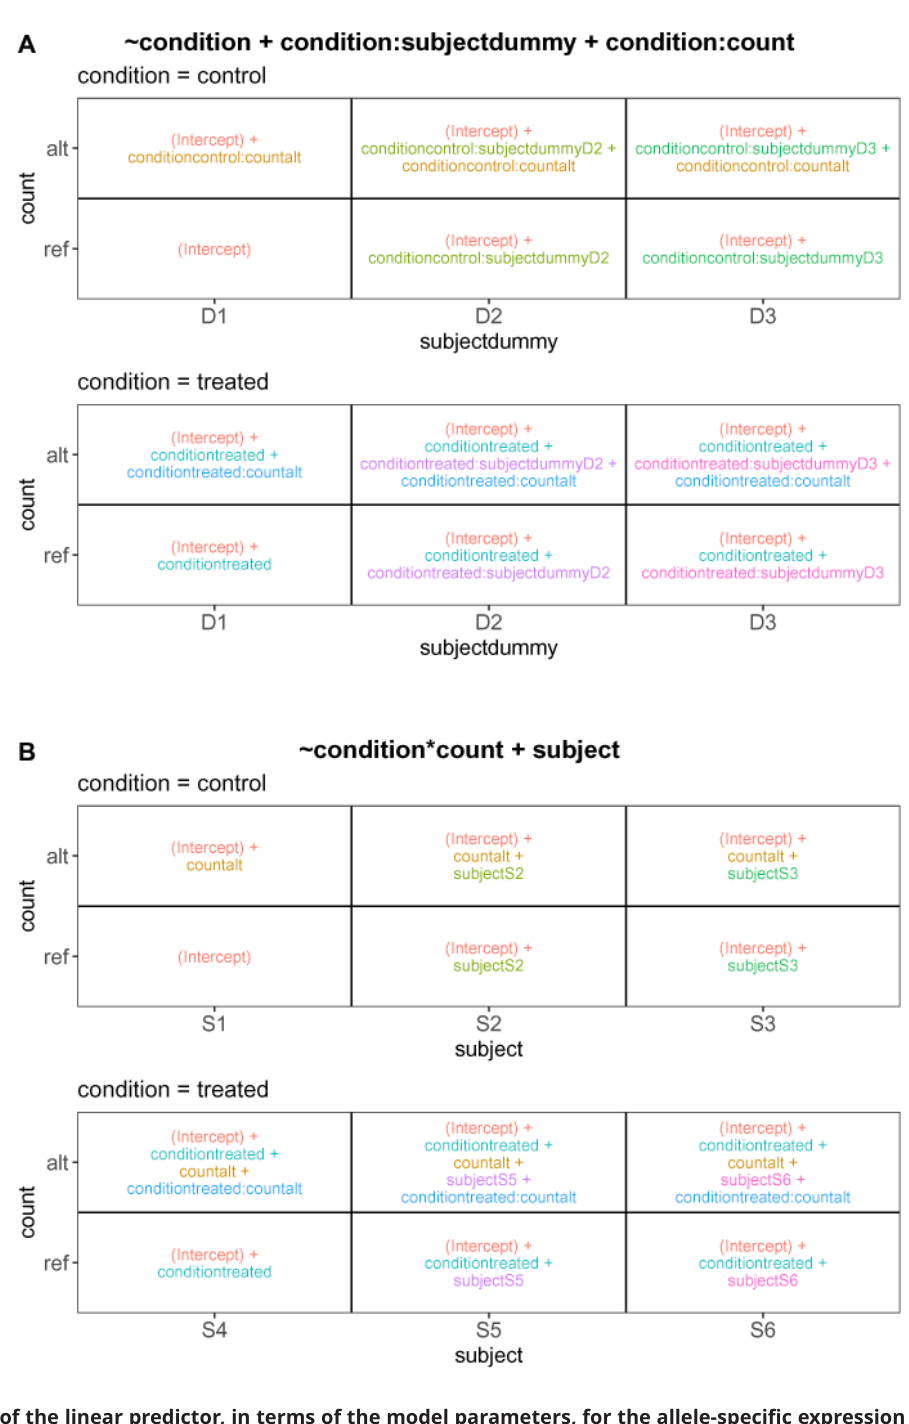
Figure 3. Values of the linear predictor, in terms of the model parameters, for the allele-specific expression use case. A . Using the design formula ~ condition + condition:subjectdummy + condition:count. B . Using the design formula ~ condition*count +